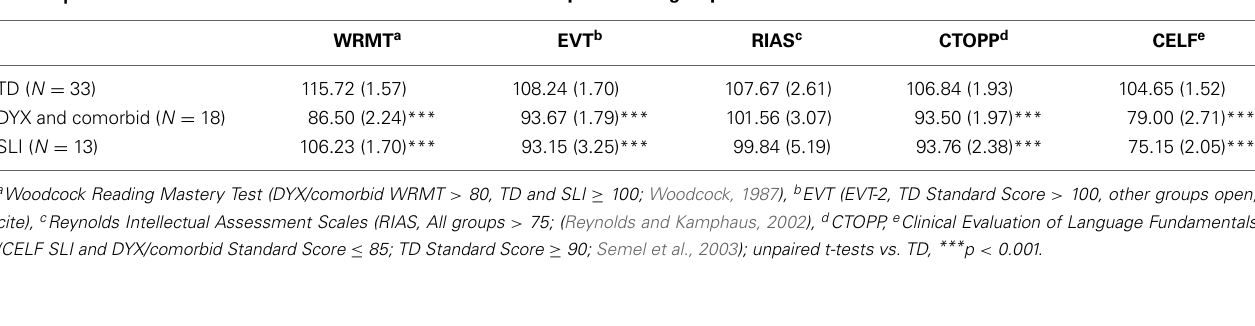
Table 1 | Standardized scores and criteria for inclusion in each experimental